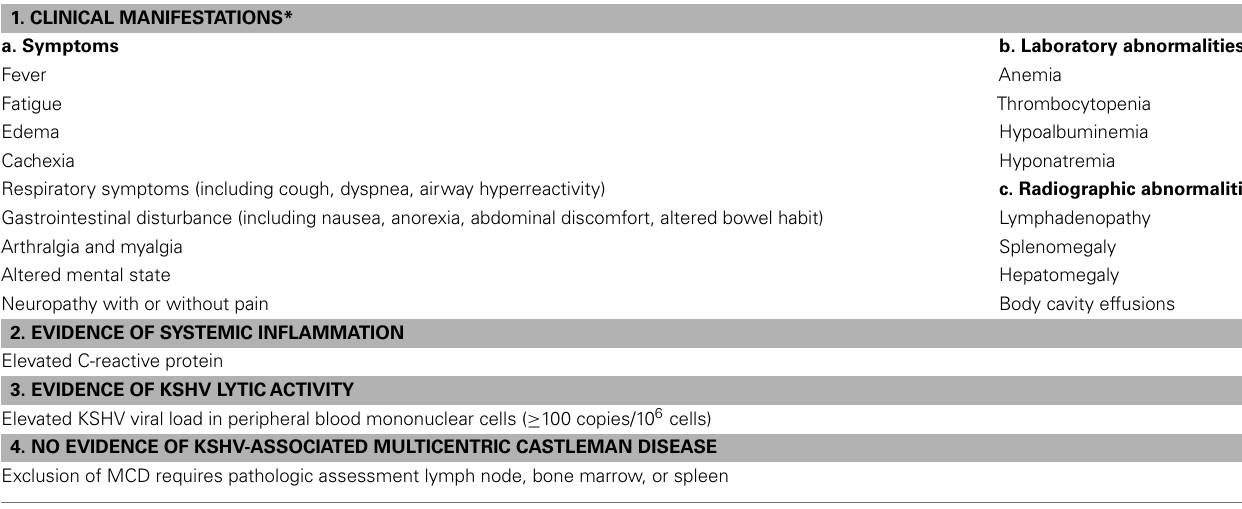
Table 2 | Proposed working case definition of KSHV inflammatory cytokine